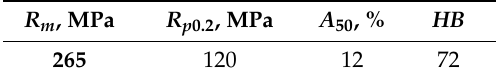
Table 1. Mechanical properties of AW5083 aluminum alloy.